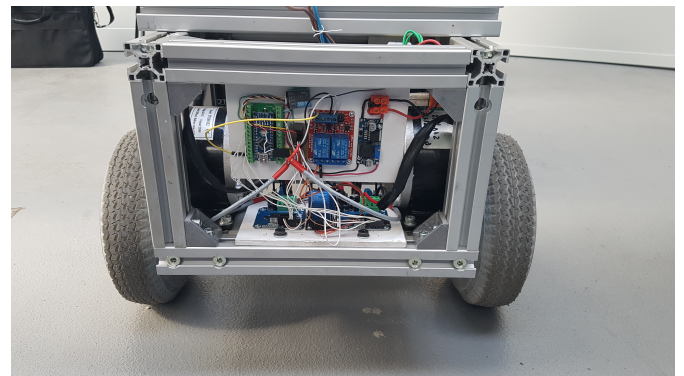
Figure 9. Hardware of control